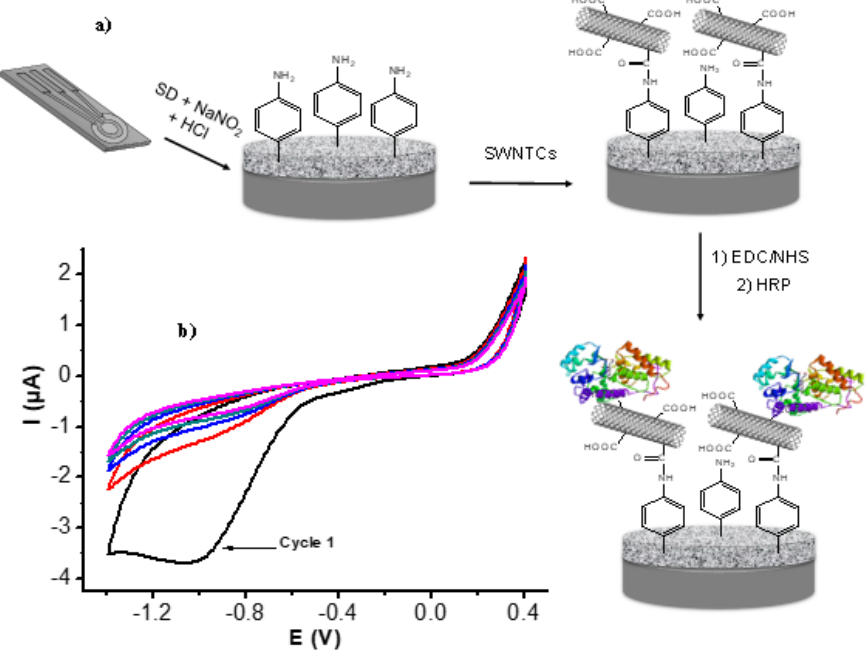
Figure 3. ( a ) Schematic illustration of the different steps of the biosensor fabrication; ( b ) Cyclic volt- ammograms of DS electropolymerization. voltammograms of DS